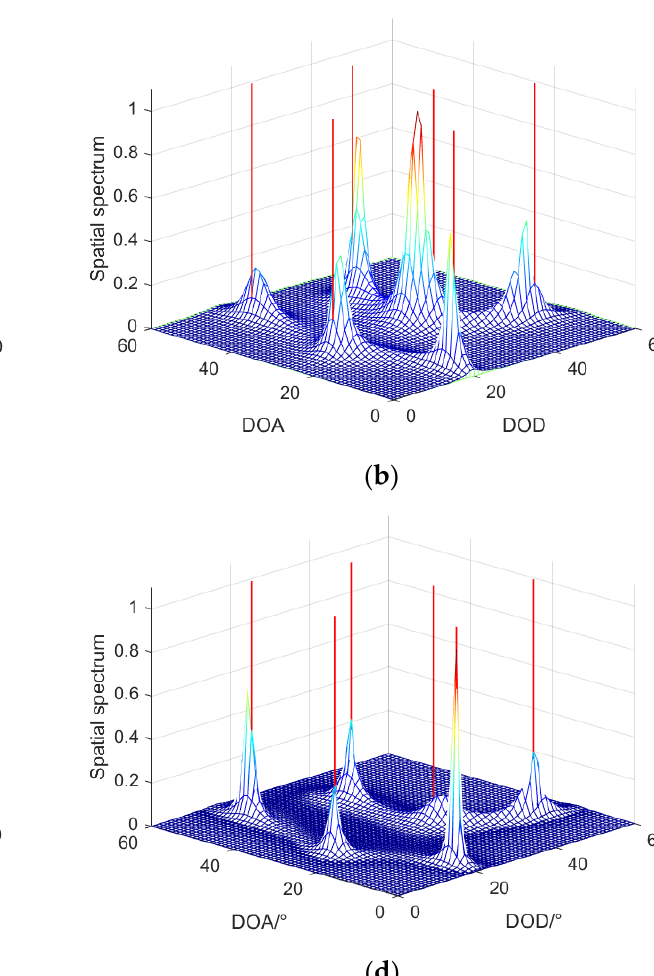
( d ) Figure 3. Results of estimating 10 targets by different algorithms: ( a ) LMR algorithm; ( b ) SMS algo- rithm; ( c ) ASDS algorithm; ( d ) TRDS algorithm. 4.2. Spatial Spectrum Estimation In this part, we assumed that the number of snapshots was 200 and the SNR was 10 dB. The DODs of targets were { 50 , 5 , 15 , 25 , 45 , 25 } , the DOAs of targets were { 15 , 20 , 50 , 10 , 35 , 35 } , and the estimated targets were six fully coherent signals. Figure 4 shows the spatial spectrum of the DOD and DOA joint estimation for the coherent targets. The red lines denote the true angles of six targets, and the spectral peak denotes the estimated angles of six targets. The four figures in Figure 4 are as follows: (a) LMR algorithm; (b) SMS algorithm; (c) ASDS algorithm; and (d) TRDS algorithm. Figure 4a shows that the spatial spectral peaks completely overlapped with the red line, so we could use the LMR algorithm to obtain a clear spatial spectral peak map. However, the